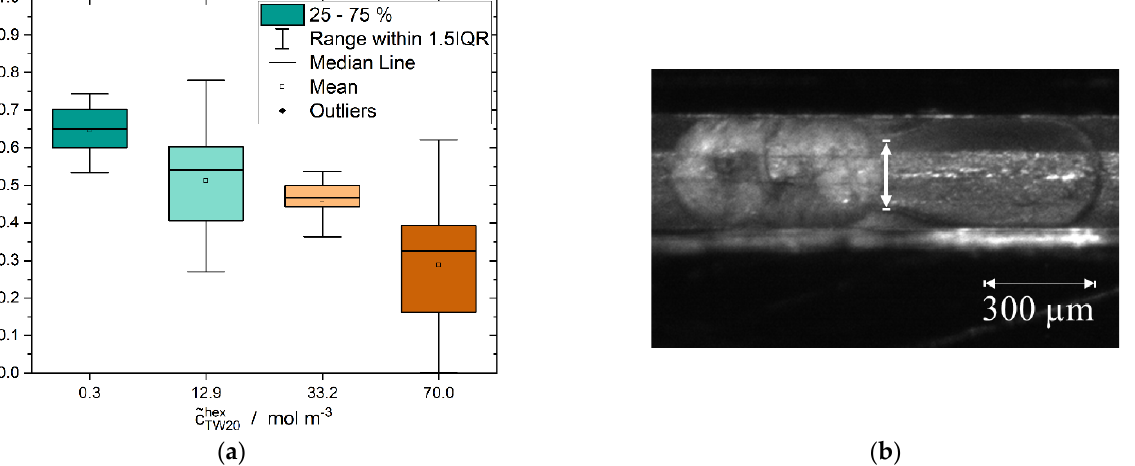
Figure 12. ( a ) Dimensionless diameter of the liquid bridge between the solid particle and the liquid droplet shortly after formation for all relative velocities tested. The emulsifier was dissolved in the dispersed phase at different concentrations at the beginning of the experiment. ( b ) Determination of the diameter of the liquid bridge formed during CMN between a solid and liquid n-hexadecane droplet in a microfluidic channel. The images used for the determination of the diameter of the bridge were taken directly after contact of the droplets, with the maximum error between the moment of contact and the picture shot being 𝑡 = 0.01 s.